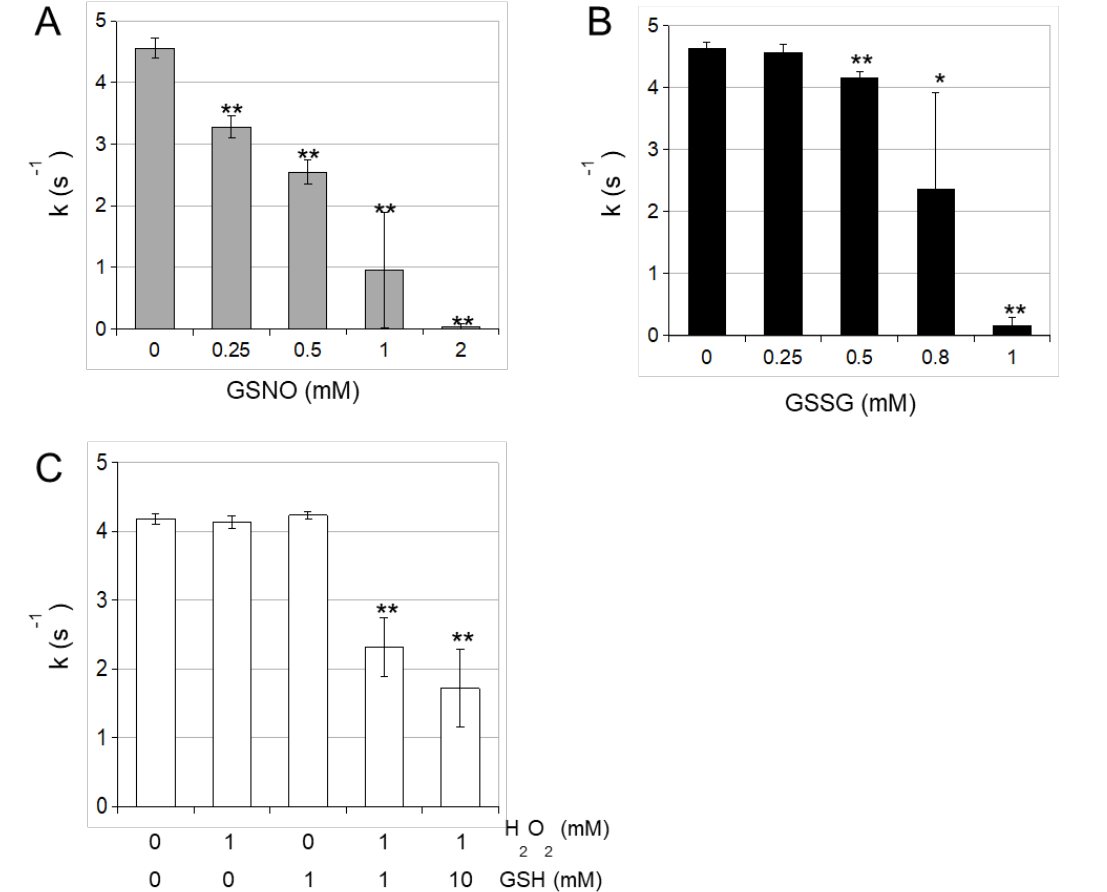
Figure 2. Cytosolic ICDH activity is sensitive to oxidation. 4.38 µ M (200 ng/ µ L) ICDH were incubated with different concentrations of ( A ) H 2 O 2 /GSH, ( B ) nitrosoglutathione (GSNO) or ( C ) oxidized glutathione (GSSG) for 15 min at 25 ◦ C. This reaction mixture was diluted 250 times in reaction buffer during the assay. ICDH activity was measured for 800 ng of ICDH at 25 ◦ C in 1 mL reaction medium containing 100 mM phosphate buffer (KOH, pH 7.5), 5 mM MgCl2, 250 µ M of NADP + and 2.5 mM DL-isocitric acid by monitoring the change in absorbance at 340 nm due to the isocitrate-dependent rate of NADP + reduction. Error bars represent SE ( n = 3). * p < 0.05, ** p < 0.01 for statistical differences compared to non-treated samples (Student’s t